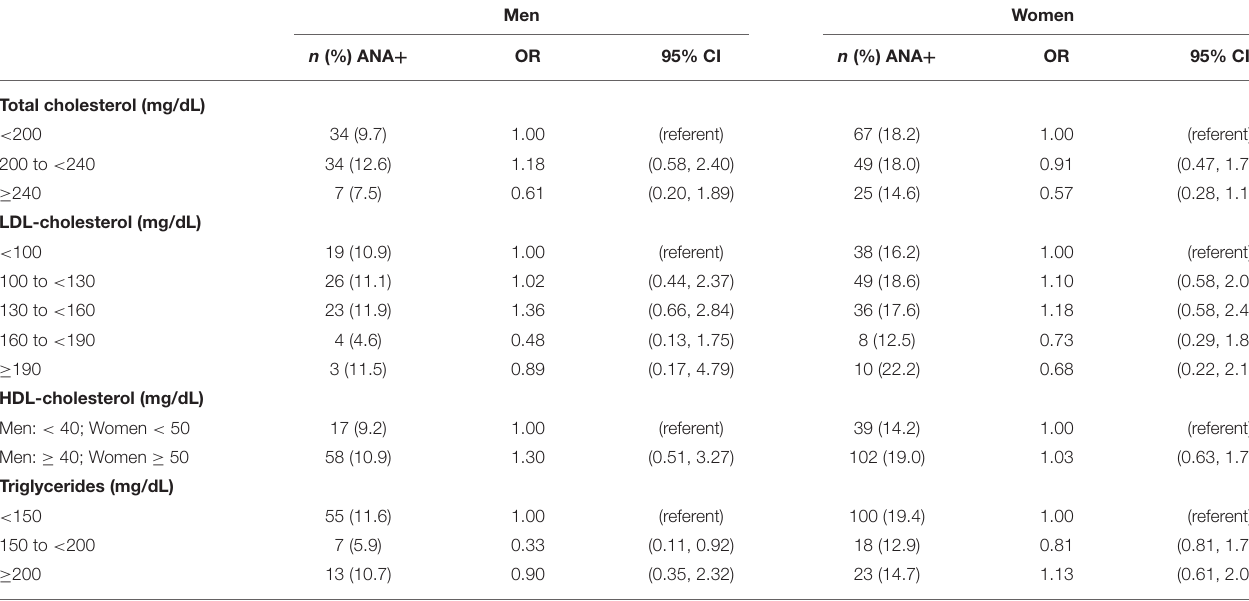
TABLE 3 | Association between blood lipids and ANA positivity among adults ≥ 20 years of age in NHANES 1999–2004 ( n = 1,526). Men